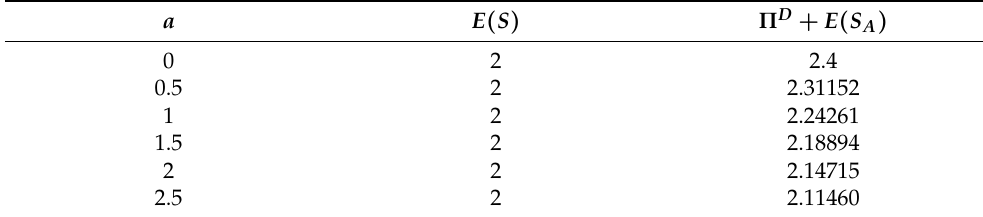
Table 2. E ( S ) and Π D + E ( S A ) for different values of a .